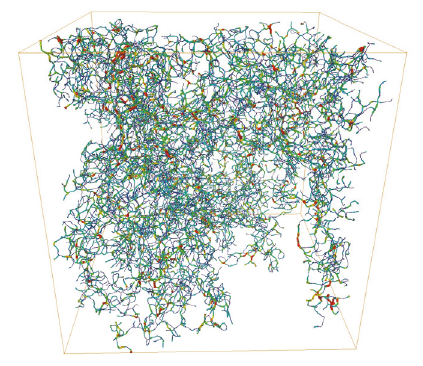
Figure 11: The pore throat connectivity of IG-110.